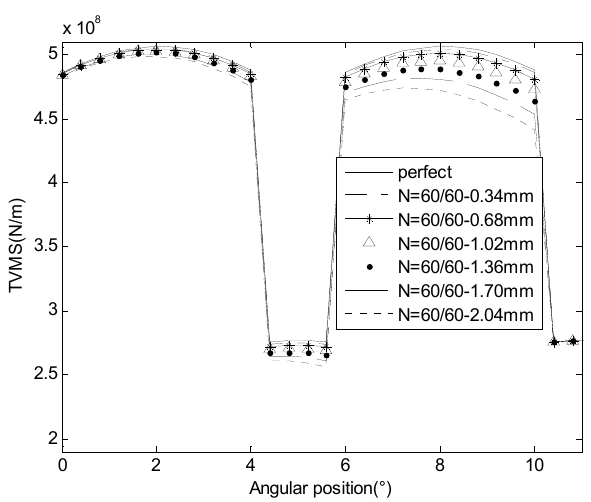
Figure 25. Meshing stiffness of cracked gears with 60/60 teeth.